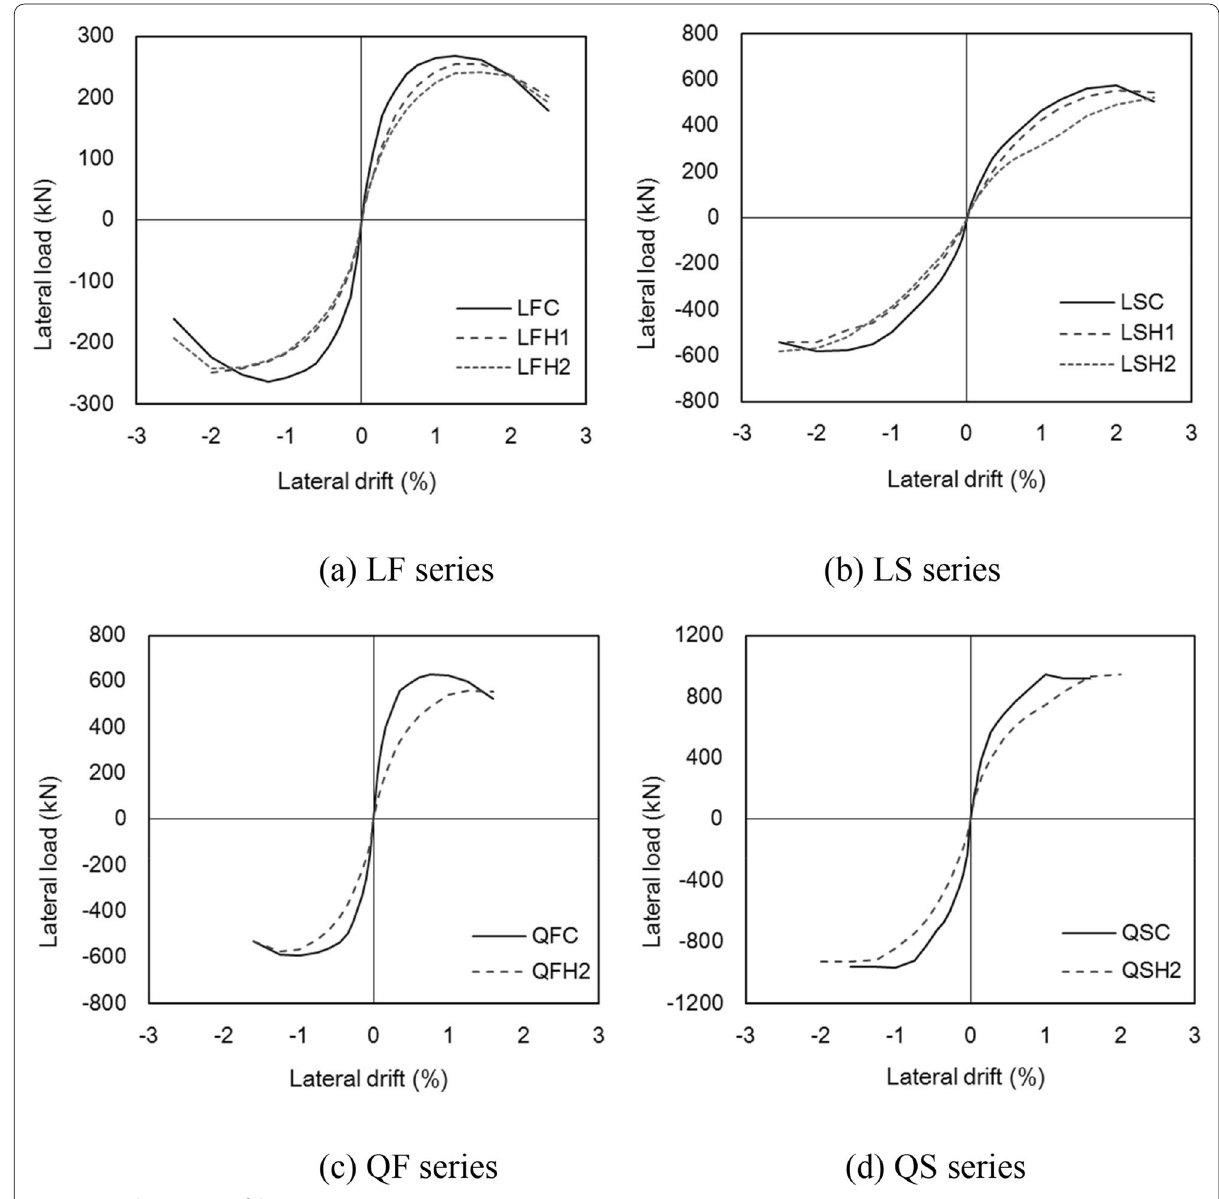
Fig. 14 Envelope curves of the